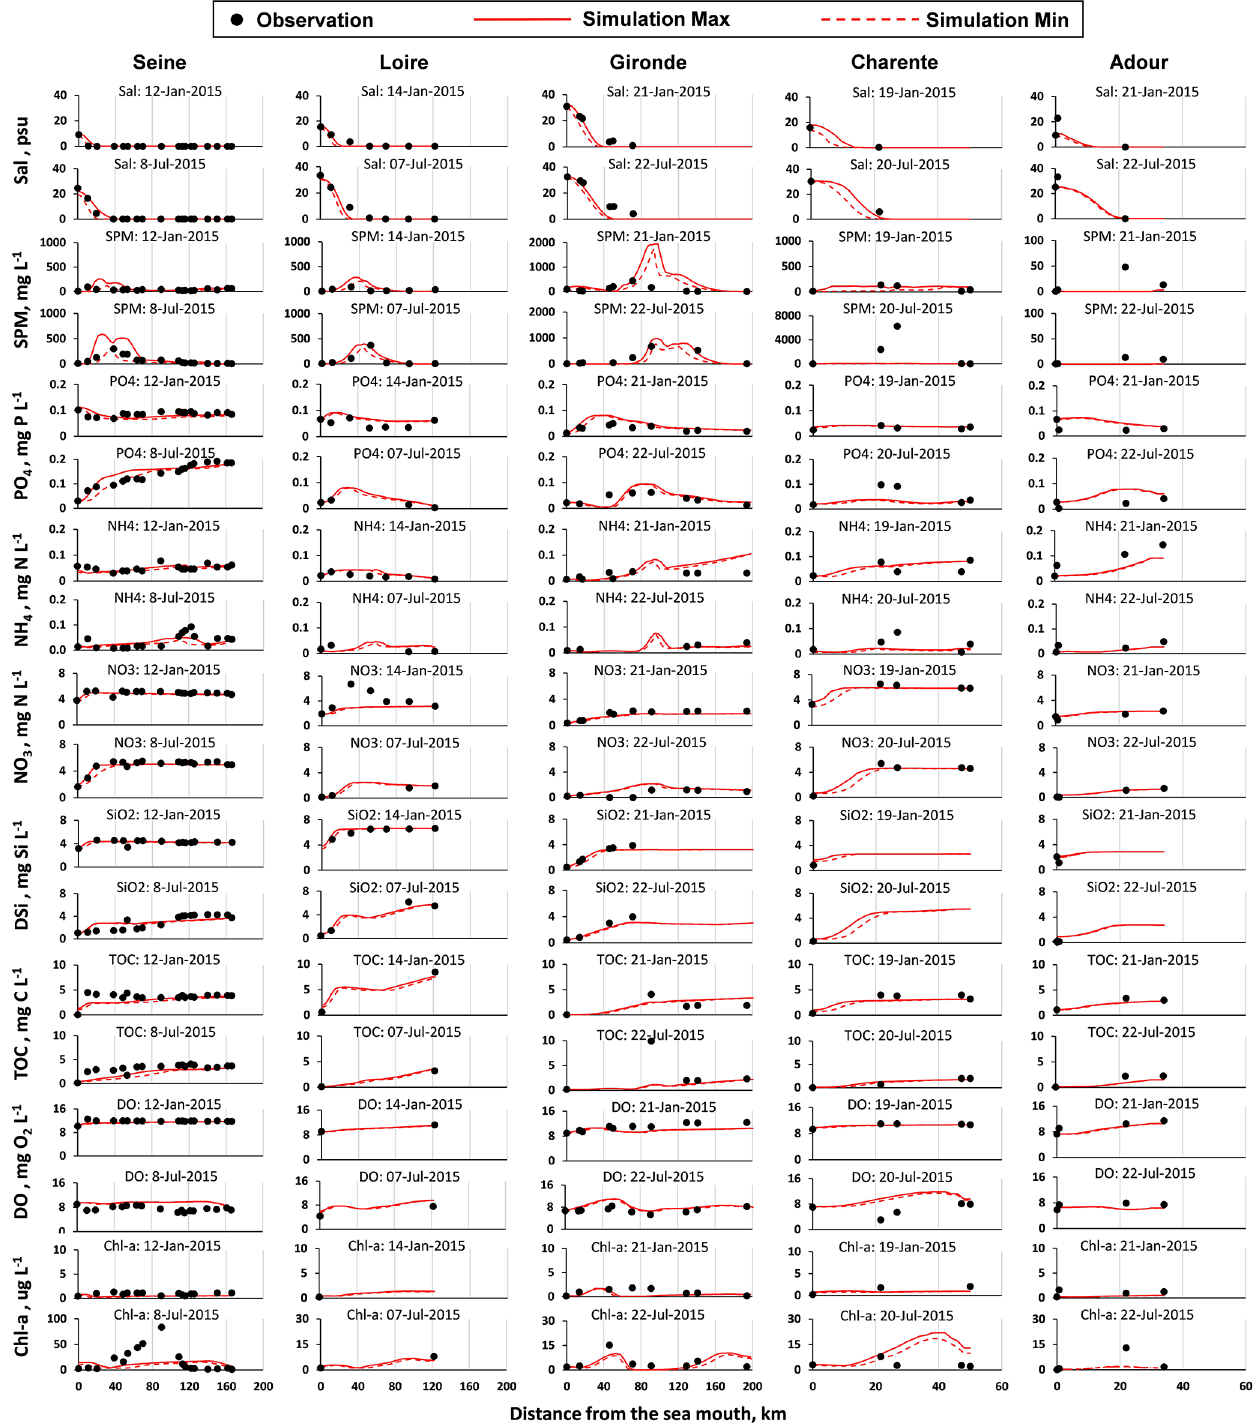
Figure 3. Salinity (Sal), suspended particulate matter (SPM), and nutrients (PO 4 , NH 4 , NO 3 , DSi, and TOC), dissolved oxygen (DO), and chlorophyll a (Chl a ) concentration variations along the estuaries (the Seine, Loire, Gironde, Charente, and Adour) for two selected dates (one in winter and the other one in summer). Note the different scales for the SPM and Chl a for the estuaries. The results of the Somme and Vilaine estuaries are shown in the